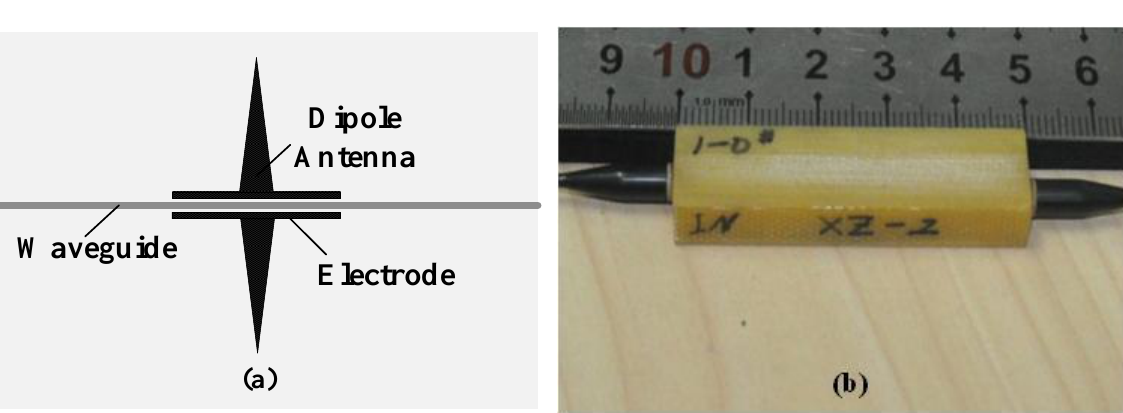
Figure 17. The CPI-based IOES with dipole antenna and electrode. ( a ) Schematic of the sensor; ( b ) Fabricated sensor with dimensions of 5 × 1.2 × 0.5 cm 3 .